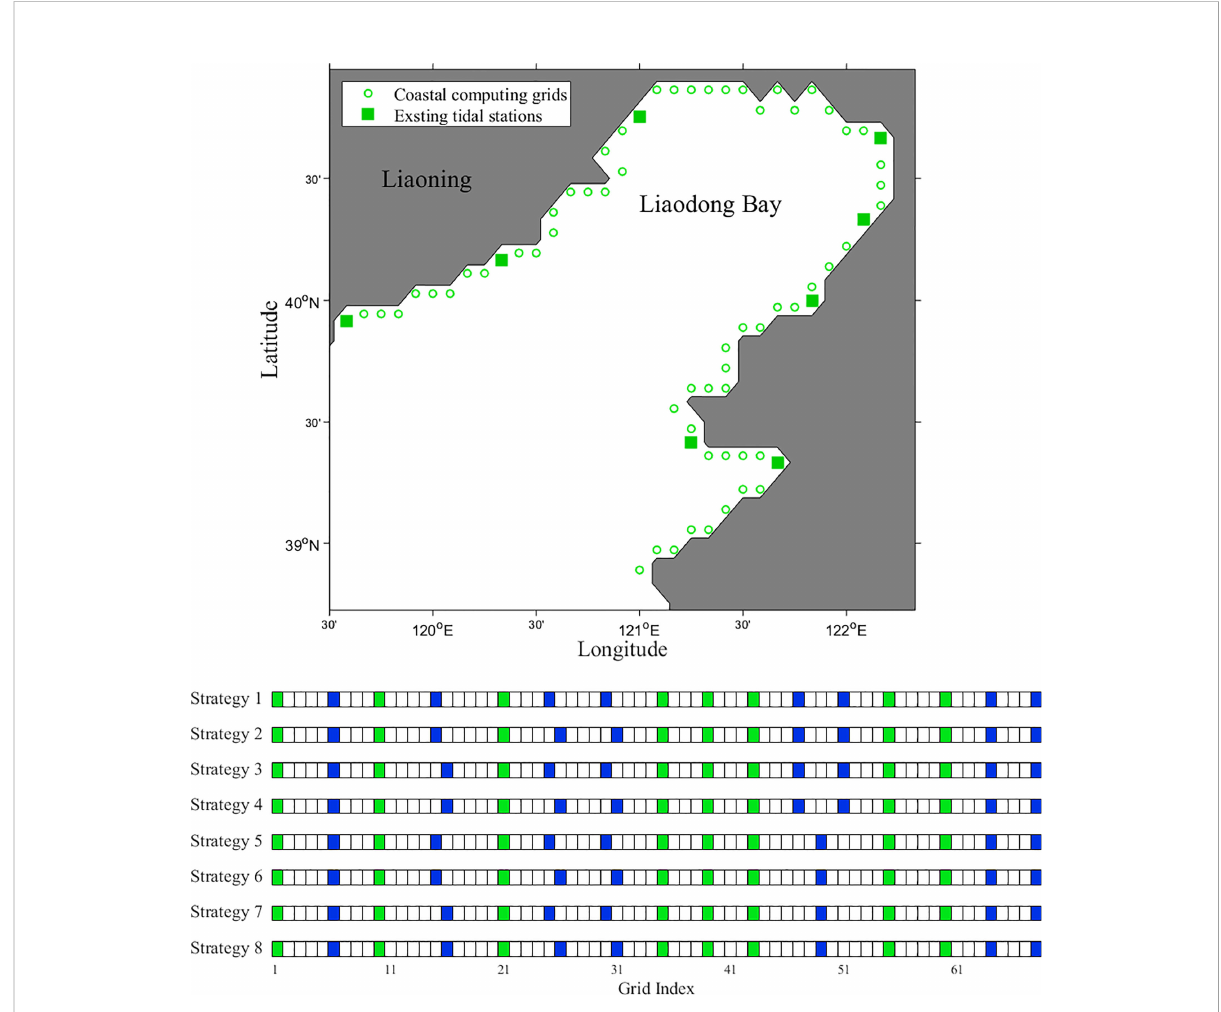
FIGURE 8 The map of subdomain in the north of the Bohai Sea and eight different siting strategies in the form of grid (the green grids represent existing tidal stations and the blue grids represent new tidal stations).